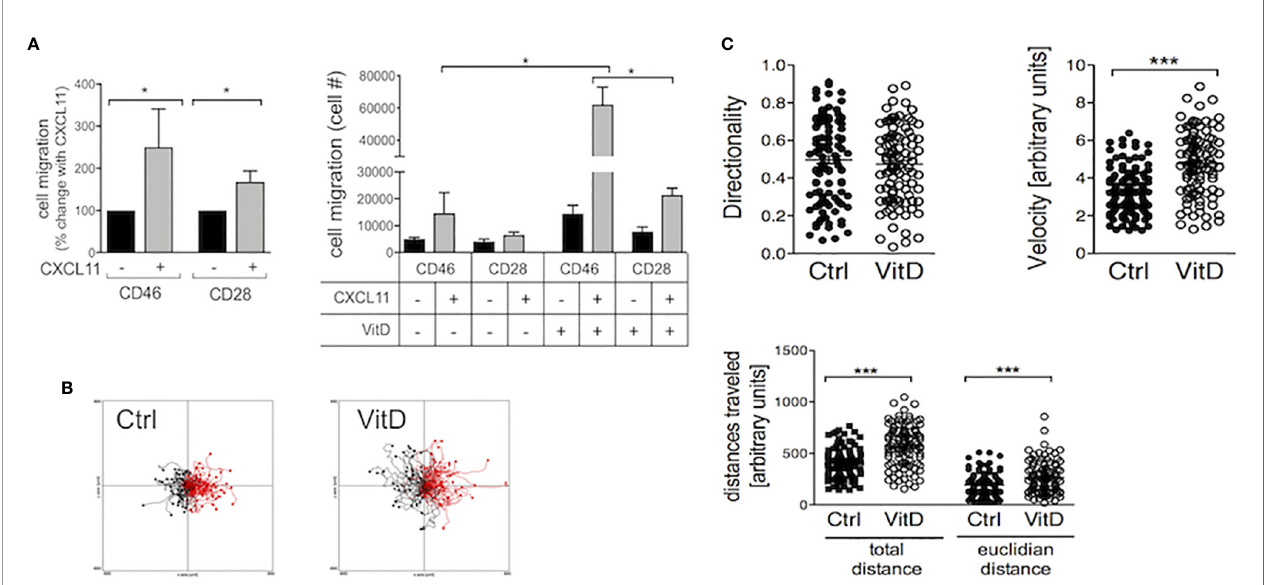
FIGURE 4 | 1,25(OH)2D3 favors migration of CD46-activated T cells. (A) Human CD4+ T cells were activated as indicated and chemotaxis to CXCL11 assessed by transwells after 3.5 hrs. The left panel shows the increased chemotaxis after normalization to migration in the absence of CXCL11 (n=10, mean ± SEM), and the right panel the numbers of cell migrated when the cells were activated in the presence or absence of 1,25(OH)2D3 (n=6, mean ± SEM). (B, C) CD46-costimulated T cells activated in the presence or absence of 1,25(OH)2D3 were added to Dunn chambers with CXCL11 and time-lapsed every 30 s for 30 min. Analysis of the cell movements were performed using the chemotaxis plugin from Ibidi into imageJ. *: p<0.05 to 0.01 and ***: 0.0001 to